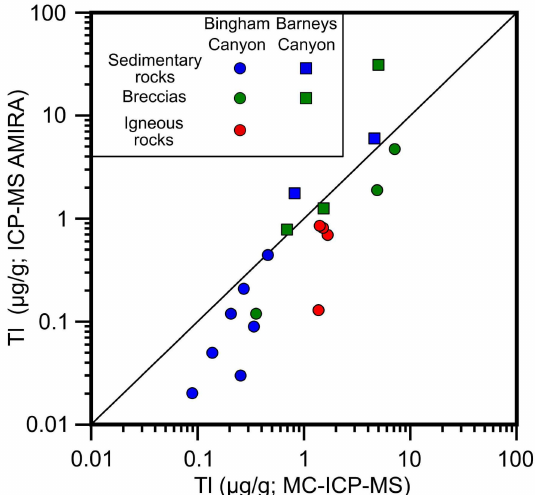
Figure 4. A plot of Tl concentrations ( µ g/g) measured by ICP-MS (during the AMIRA project (P1060)) compared to MC-ICP-MS (this study); 1:1 line provided for